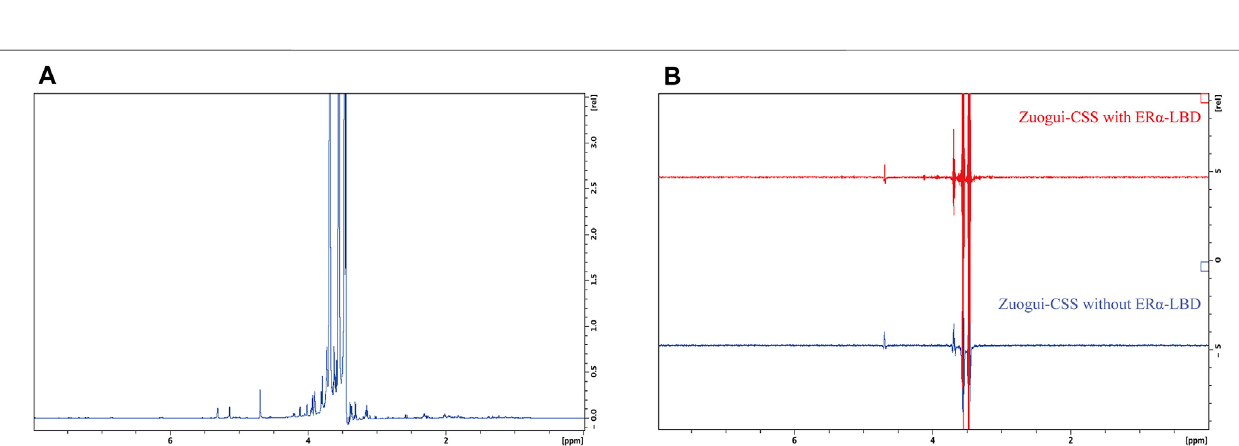
Frontiers in Pharmacology |